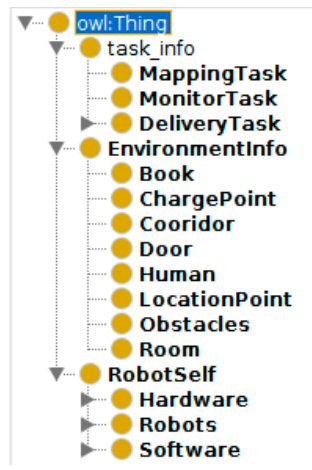
Figure 3. A snapshot of the hierarchy of the Robot Task Planning Ontology (RTPO).